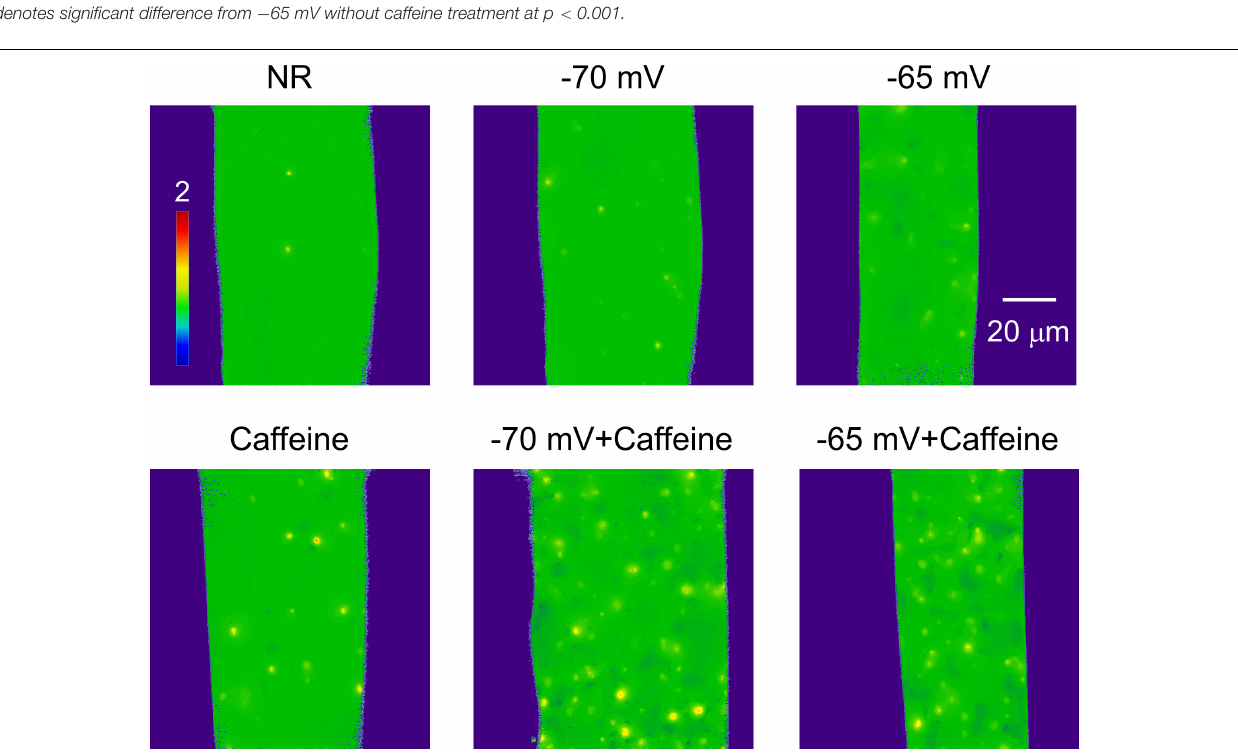
a close to linear function, as demonstrated by the superimposed dashed lines, confirming the random distribution of the